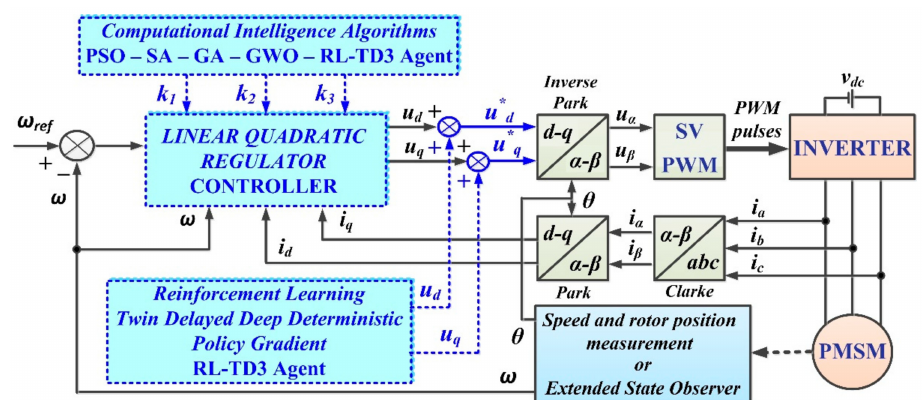
Figure 1. The proposed control block diagram of the PMSM–CS–CI based on an LQR-type controller.